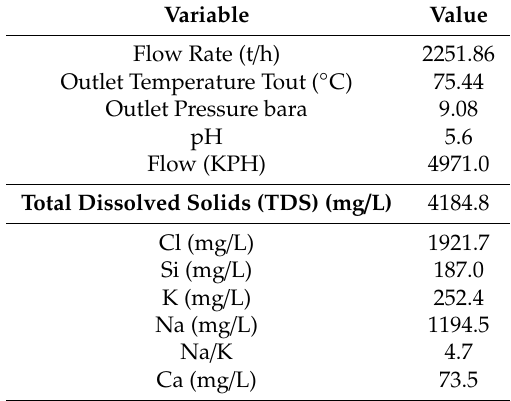
Table 2. Composition, temperature, pressure and flow data for geothermal brine leaving the Cove Fort